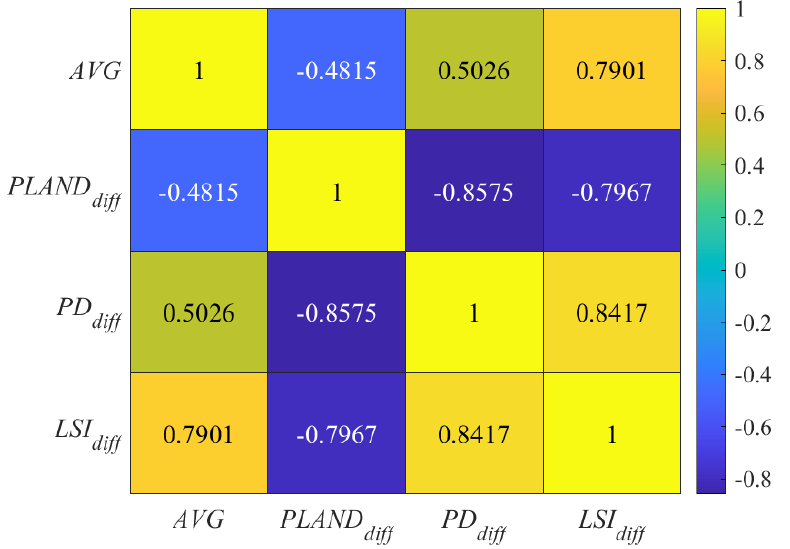
Figure 11. The correlation coefficient matrix of urban built-up area expansion indices ( 𝑈𝐵𝐴𝐸𝐼s